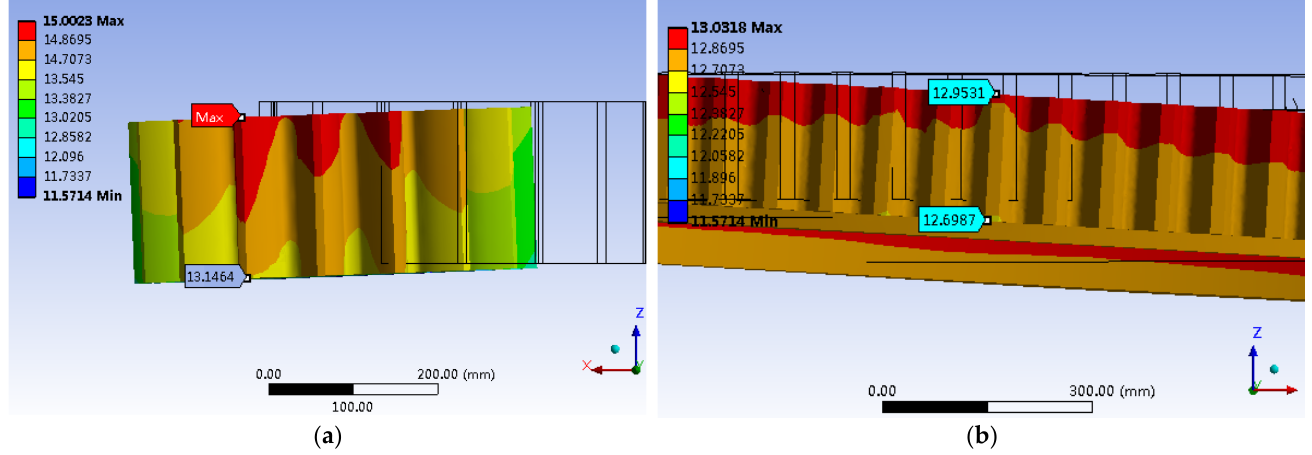
Figure 15. X -axis displacement of gear: ( a ) Pinion; ( b ) large gear ring.